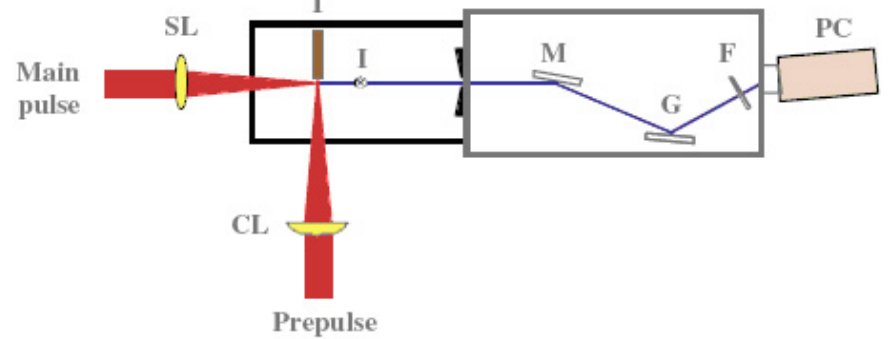
Figure 2. Diagram of the experimental setup. The symbols shown in the figure correspond to spherical lens (SL), cylindrical lens (CL), molybdenum target (T), position that is spatially imaged onto the spectrometer focal plane (I), cylindrical gold-coated mirror (M), Hitachi flat-field grating (G), 0.65 μ m thick Al foil (F), and photocathode camera